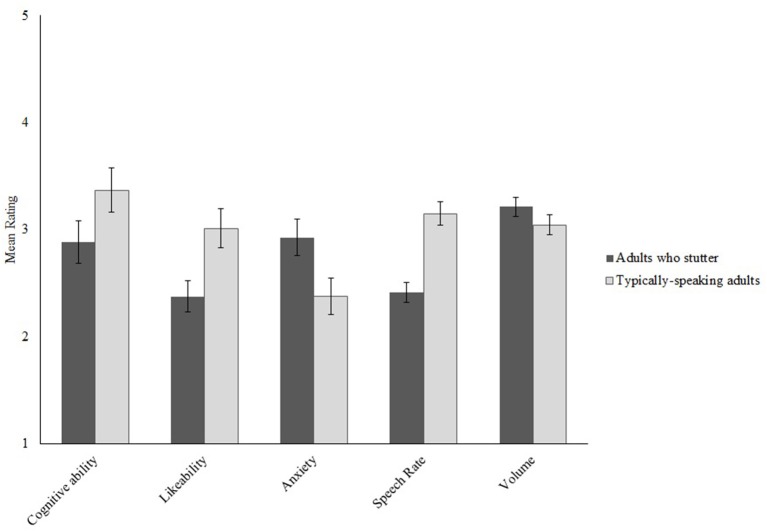
Mean ratings from Experiment 2 for each measure for adults who stutter and typically-speaking adults. Error bars indicate ±1 SEM. Higher ratings indicate greater cognitive ability, more likeable, greater anxiety, faster speech rate, and increased volume.